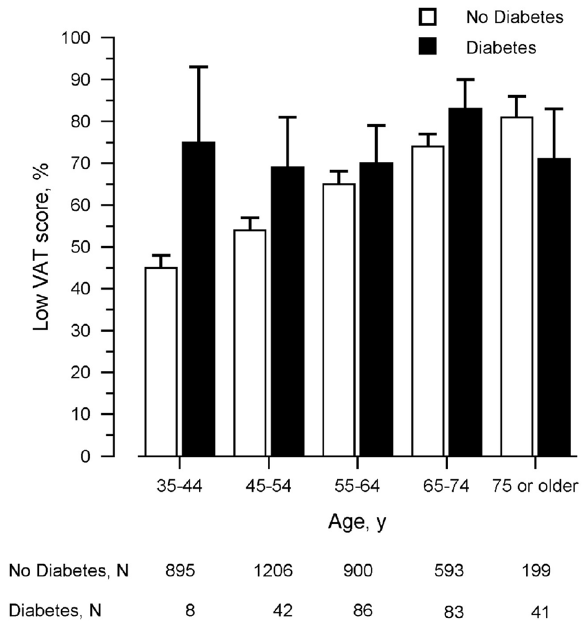
Figure 2. Percentage of persons with low performance on the VAT dependent on age and the presence of type 2 diabetes. Bars represent 95% confidence intervals. Data unadjusted for possible confounders. Abbreviation: VAT, Visual Association Test.